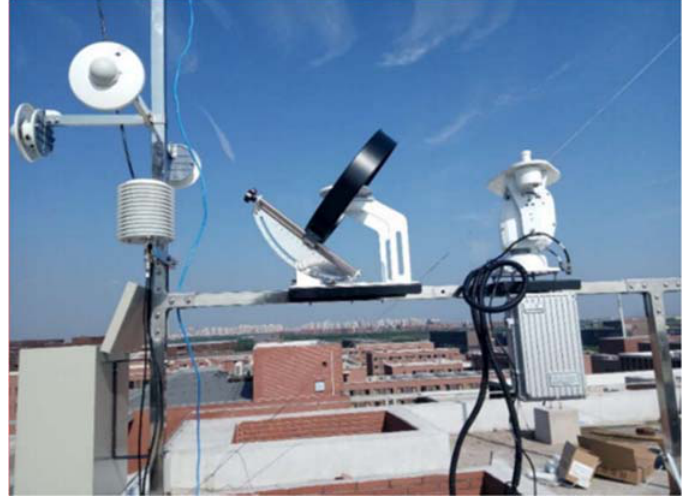
Figure 3. Meteorological station. Table 1. Measurement information of the meteorological elements.